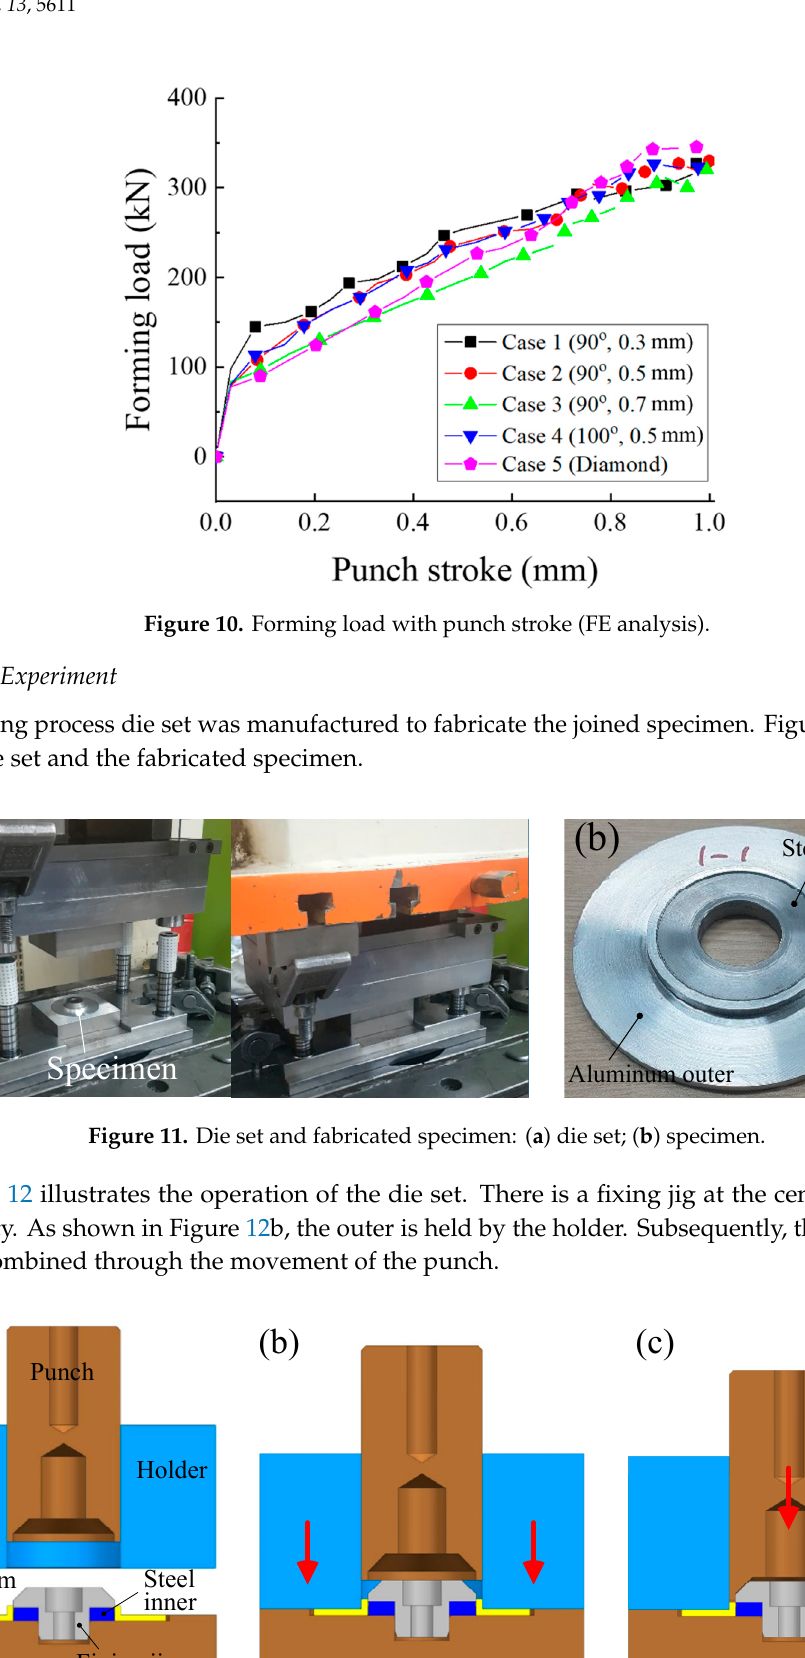
Figure 12. Die set operation: ( a ) initial setting; ( b ) outer holding; ( c ) press forming.